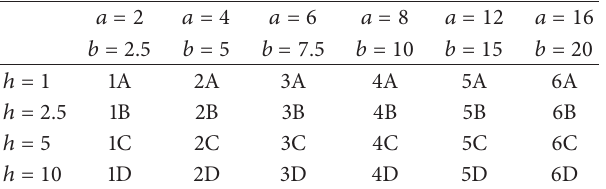
Table 1: Different dimensions [m] and depths [m] of the cave, labeled by numbers and capital letters,